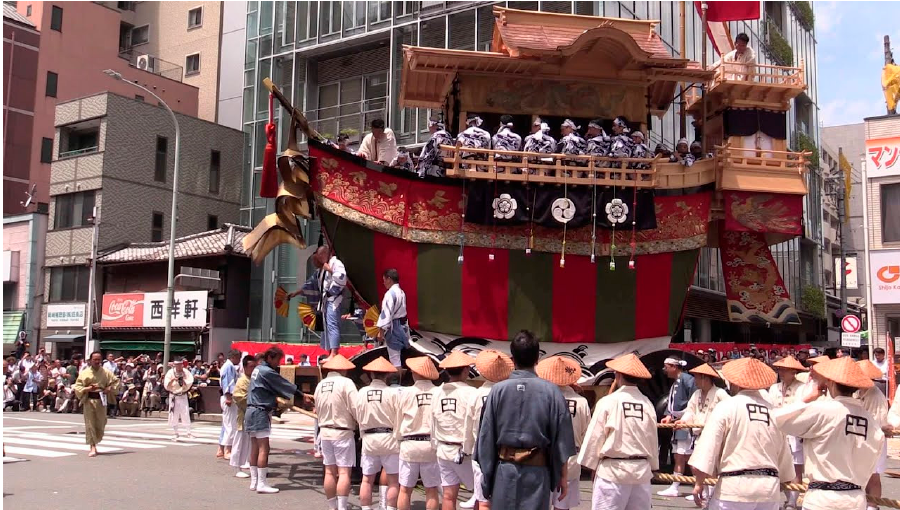
Figure 1. The Ofune-hoko float in the Gion Festival (2014).